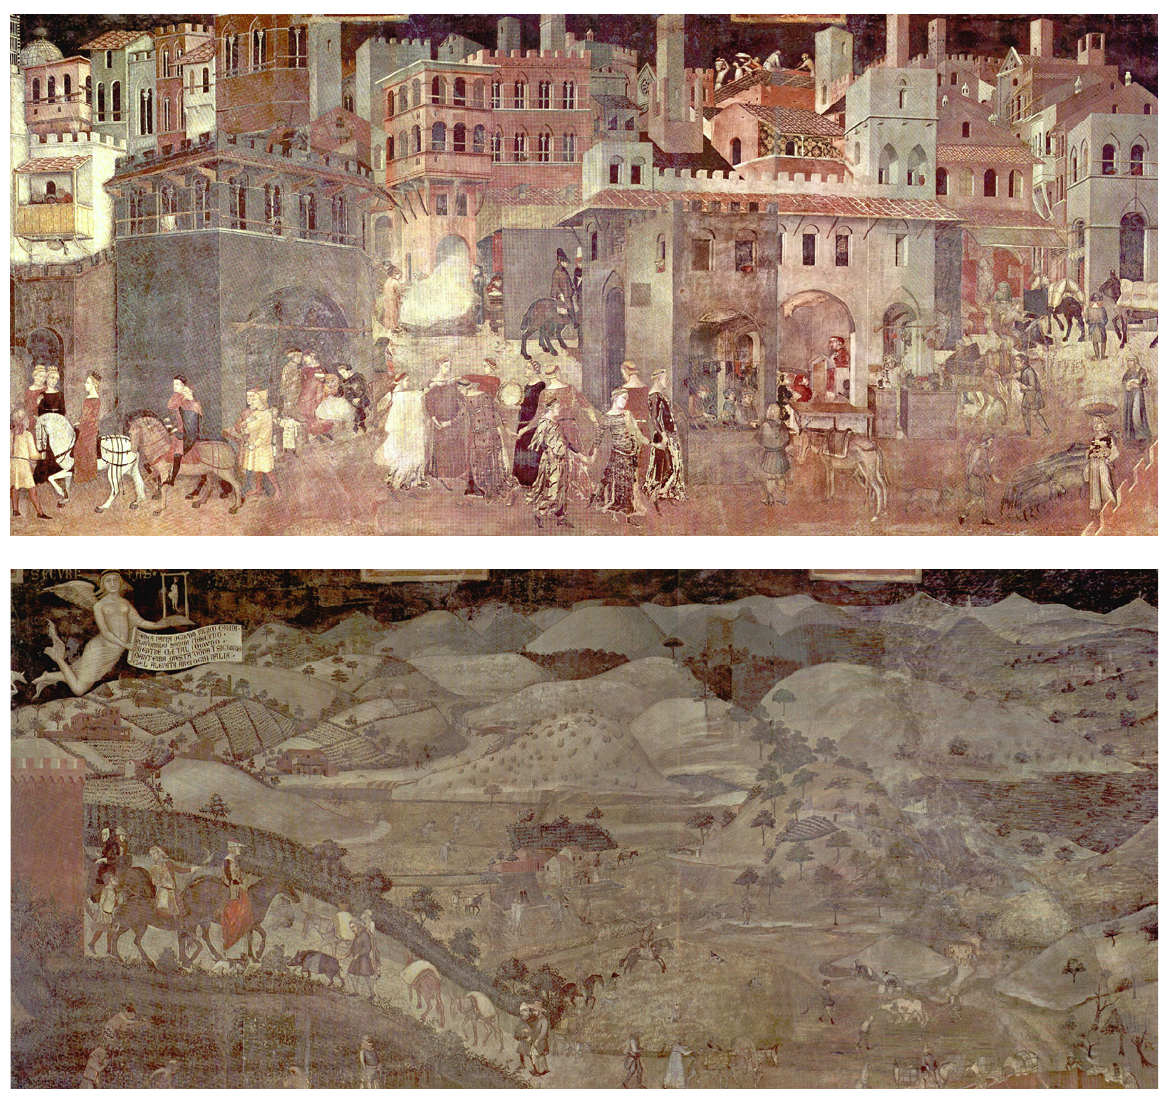
Ambrogio Lorenzetti, The Allegory of Good and Bad Government (1338-1339). Siena, Palazzo Pubblico, Image Credit: Wikimedia